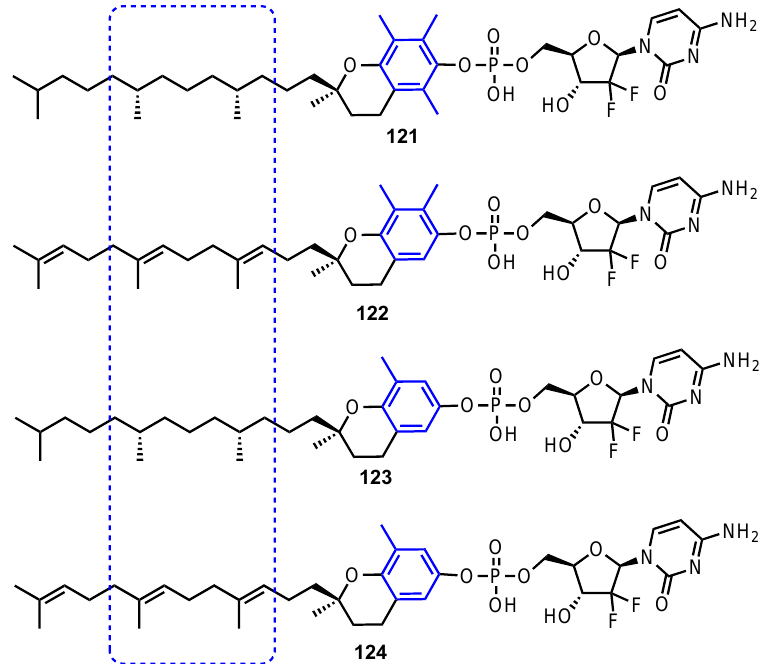
Figure 11. Structures of vitamin E-gemcitabine conjugates 121 – 124 , highlighting changes to the tocopherol or tocotrienol component.